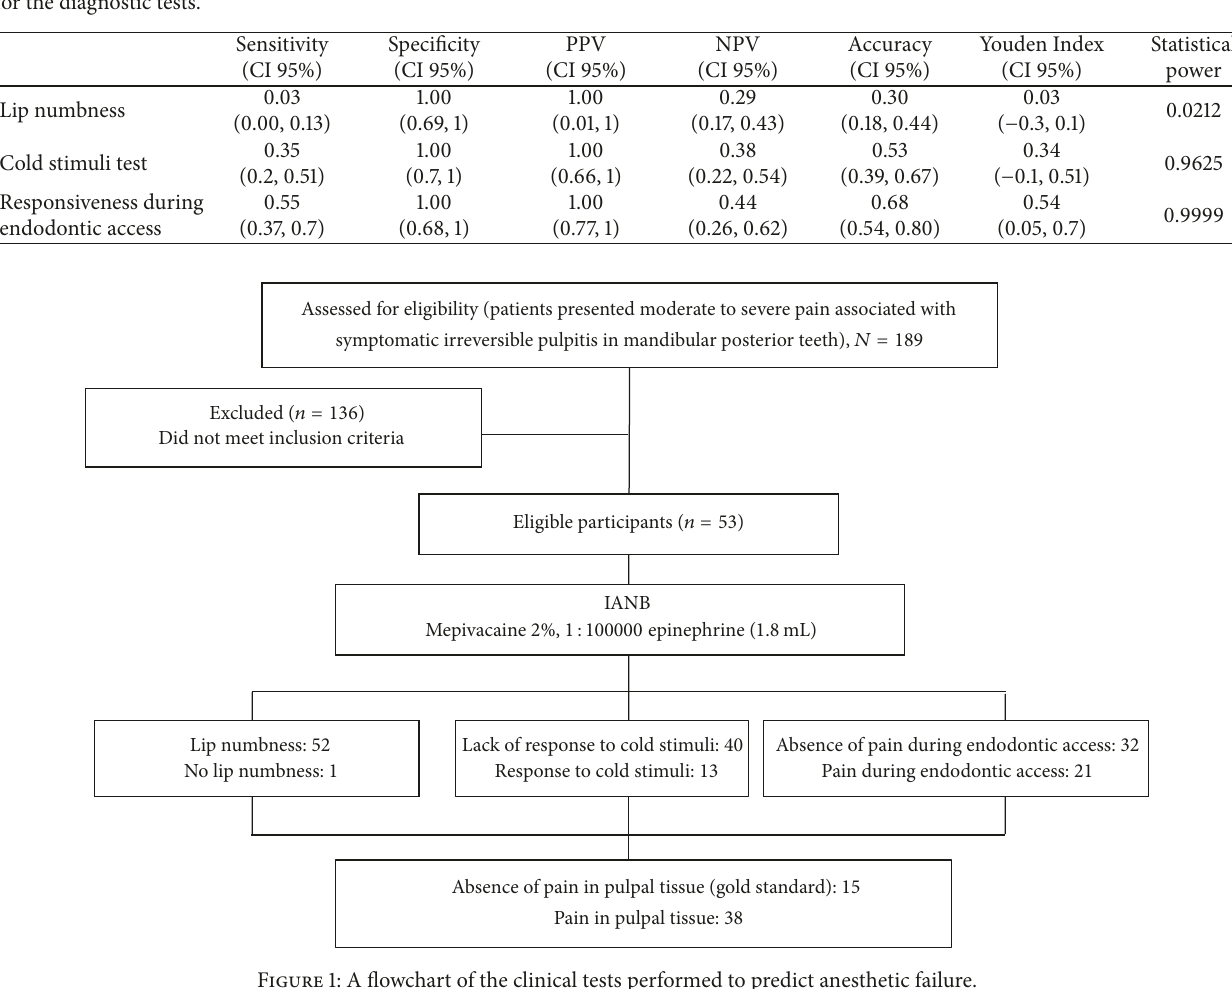
access as diagnostic tests for the detection of IANB